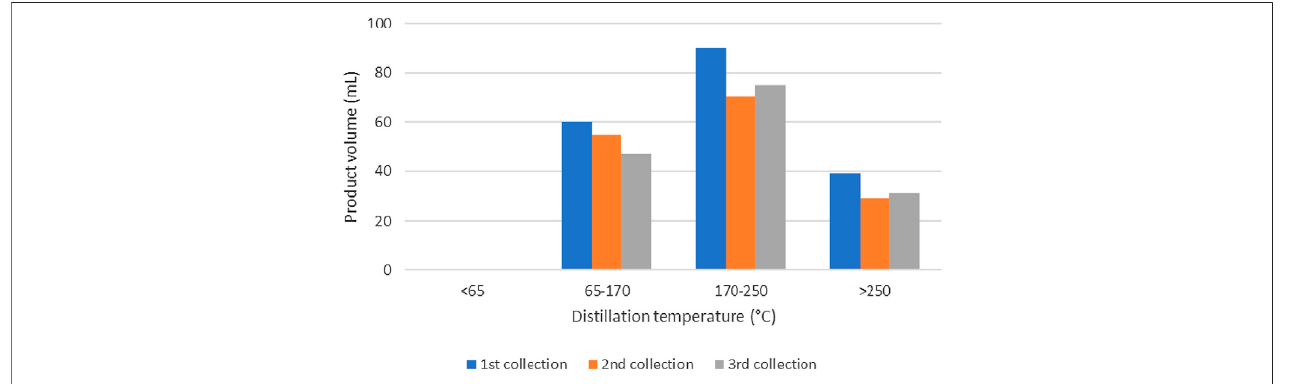
FIGURE 14 | Amount of pyrolysis oil from HDPE at different distillation temperature ranges and different collection periods.